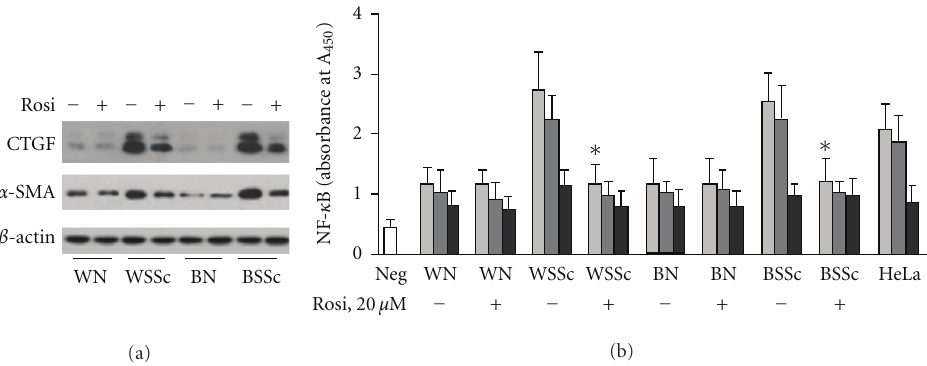
Figure 4: E ff ect of rosiglitazone on CTGF, α -SMA, and NF- κ B in lung fibroblasts isolated from white (W) and black (B) SSc-ILD patients (SSc) and controls (N). (a) Lung fibroblasts were incubated with rosiglitazone (20 μ M) for 24 hours and subjected to Western analysis for CTGF and α -SMA expression. Anti- β -actin antibody was used as a loading control. Immunoblots are representative from 5 independent experiments. (b) NF- κ B DNA-binding activity. Light gray bars: binding activity assessed by biotinylated NF- κ B wild-type (WT)